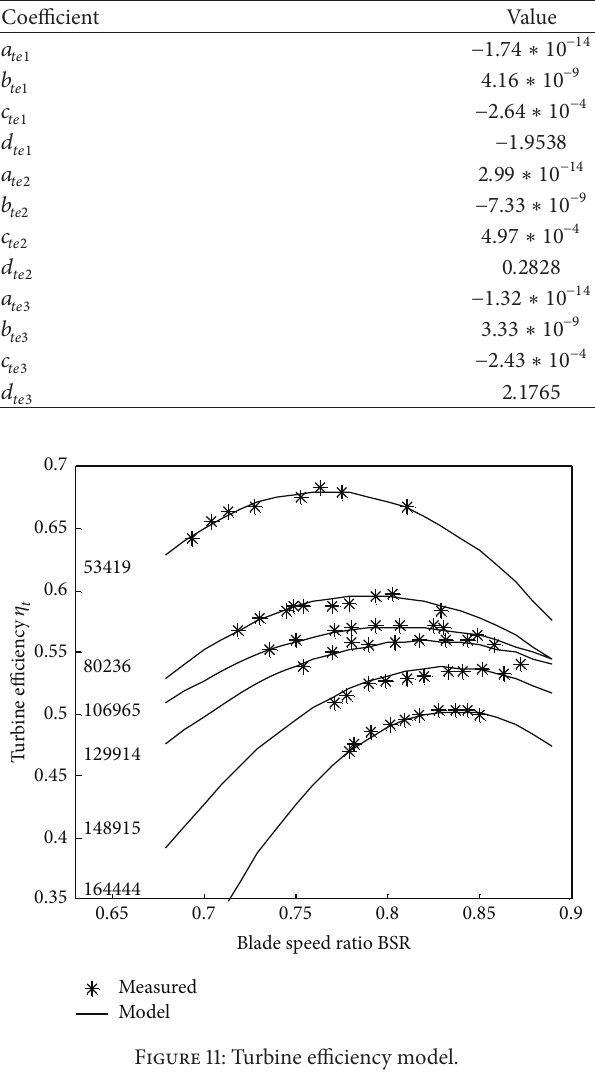
Figure 11: Turbine efficiency